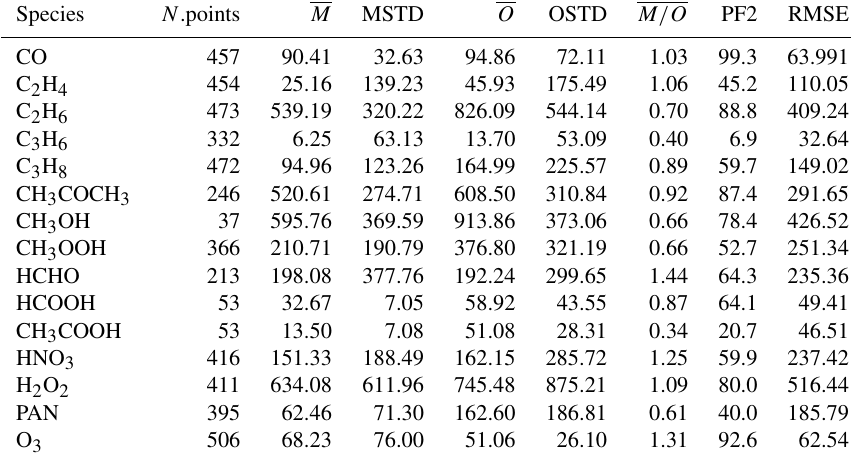
Table 3. The same as Table 2 but for the comparison of our simulation results to the dataset of Emmons et al. (2000). Species N